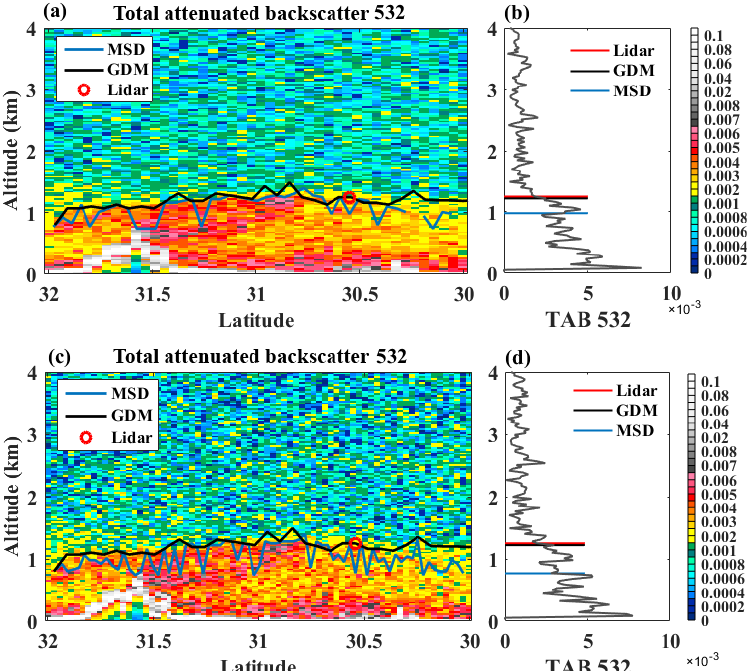
Figure 8. Total attenuated backscatter at 532nm wavelength (TAB 532 ) plot from CALIPSO on 7 October 2014 under the horizontal smooth- ing number (a) 15 and (c) 9. The corresponding vertical profile of TAB 532 derived from CALIPSO profile over Wuhan area under the horizontal smoothing number (b) 15 and (d) 9.